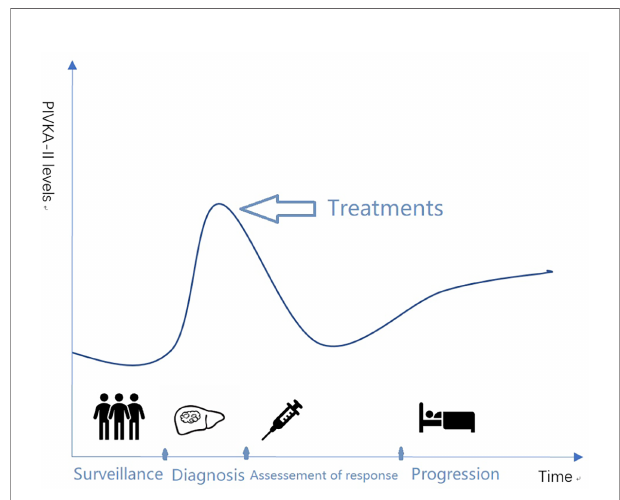
FIGURE 1 | Relative levels of PIVKA-II for HCC management.